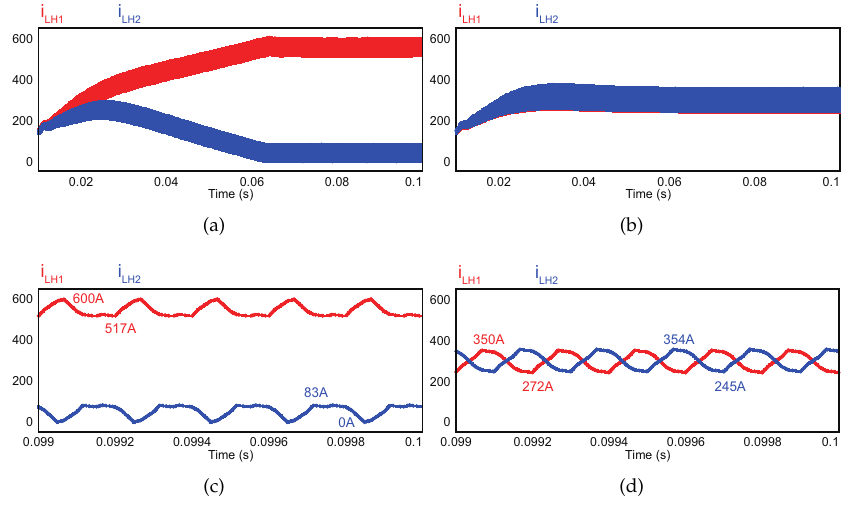
Figure 21. ( a ) current imbalance occurring during Z-type interleaving control in single current controller system; ( b ) current unbalance that does not occur during N-type interleaving control in a single current controller system ( c ) Enlarged (a); ( d ) Enlarged (b).